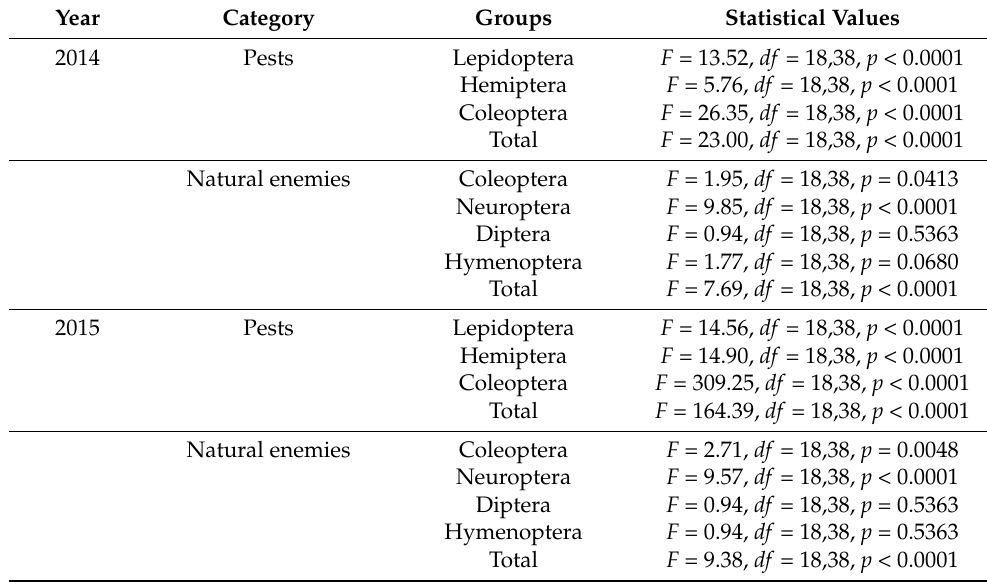
Table 2. Statistical values from the average abundance analyses of pests and natural enemies in different taxonomic groups trapped in LED traps with 19 single wavelengths during 2014–2015. Year